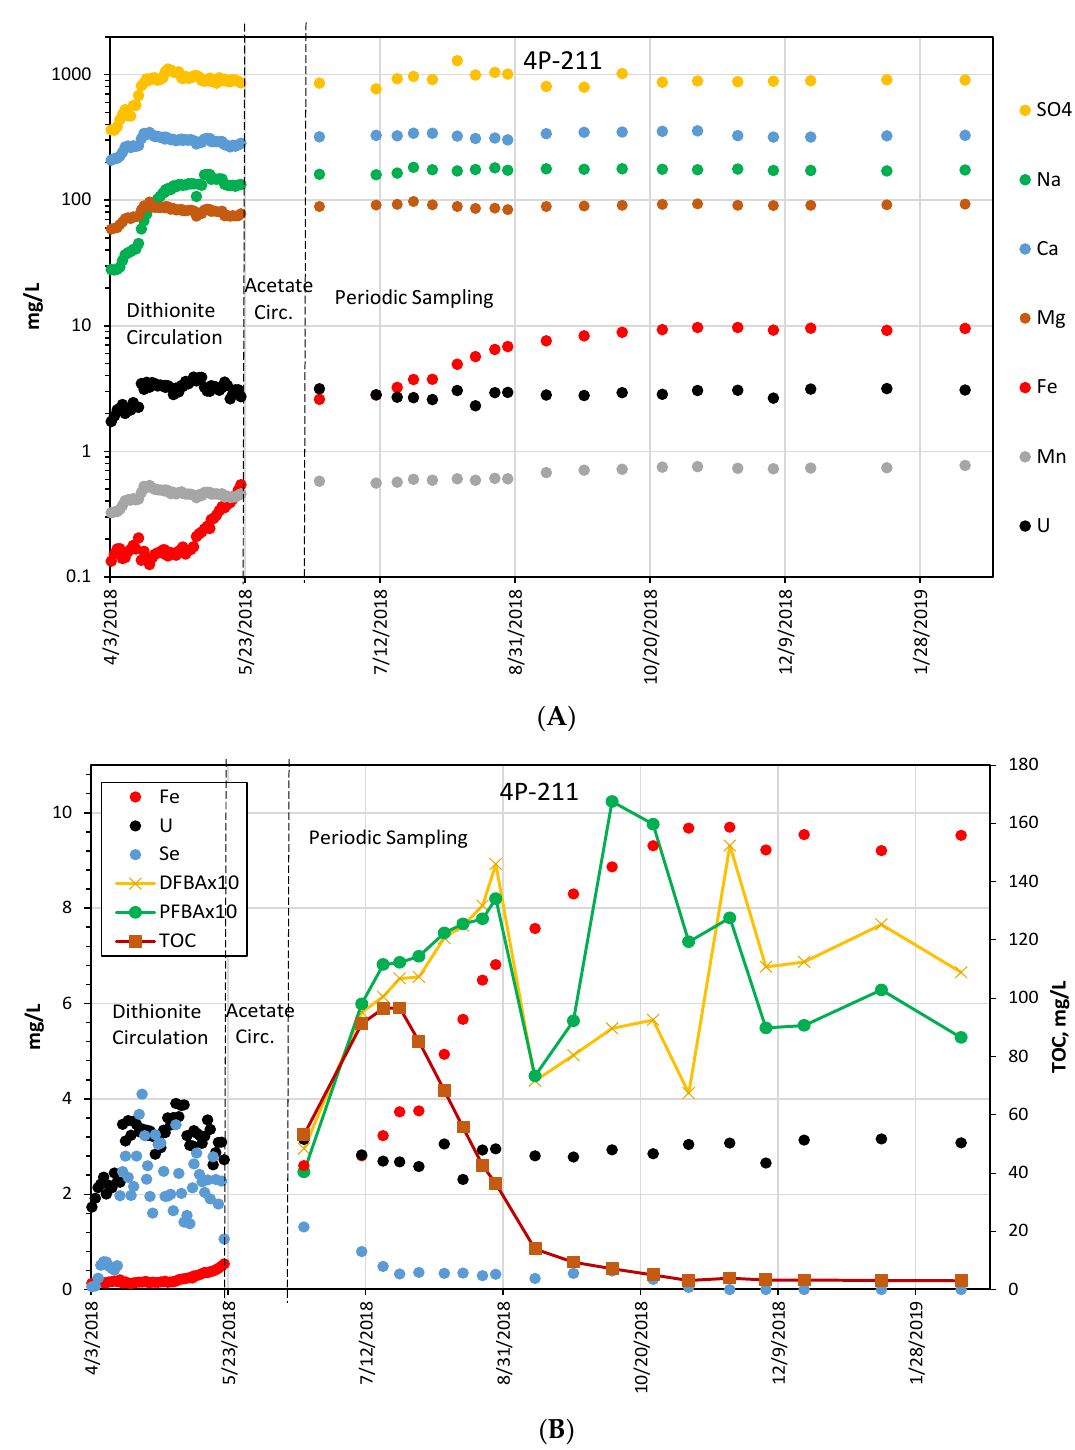
Figure A23. ( A ) Concentration histories of several key constituents in production well 4P-211 during the amendment test. ( B ) Concentration histories of redox-sensitive constituents (Fe(II), U, Se), TOC (as acetate surrogate), and tracers. Note that difluorobenzoate (DFBA) and pentafluorobenzoate (PFBA) concentrations are multiplied by 10.